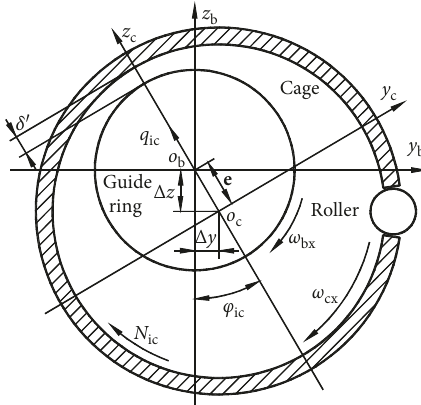
Figure 4: Interaction between the cage and guide ring (inner-ring